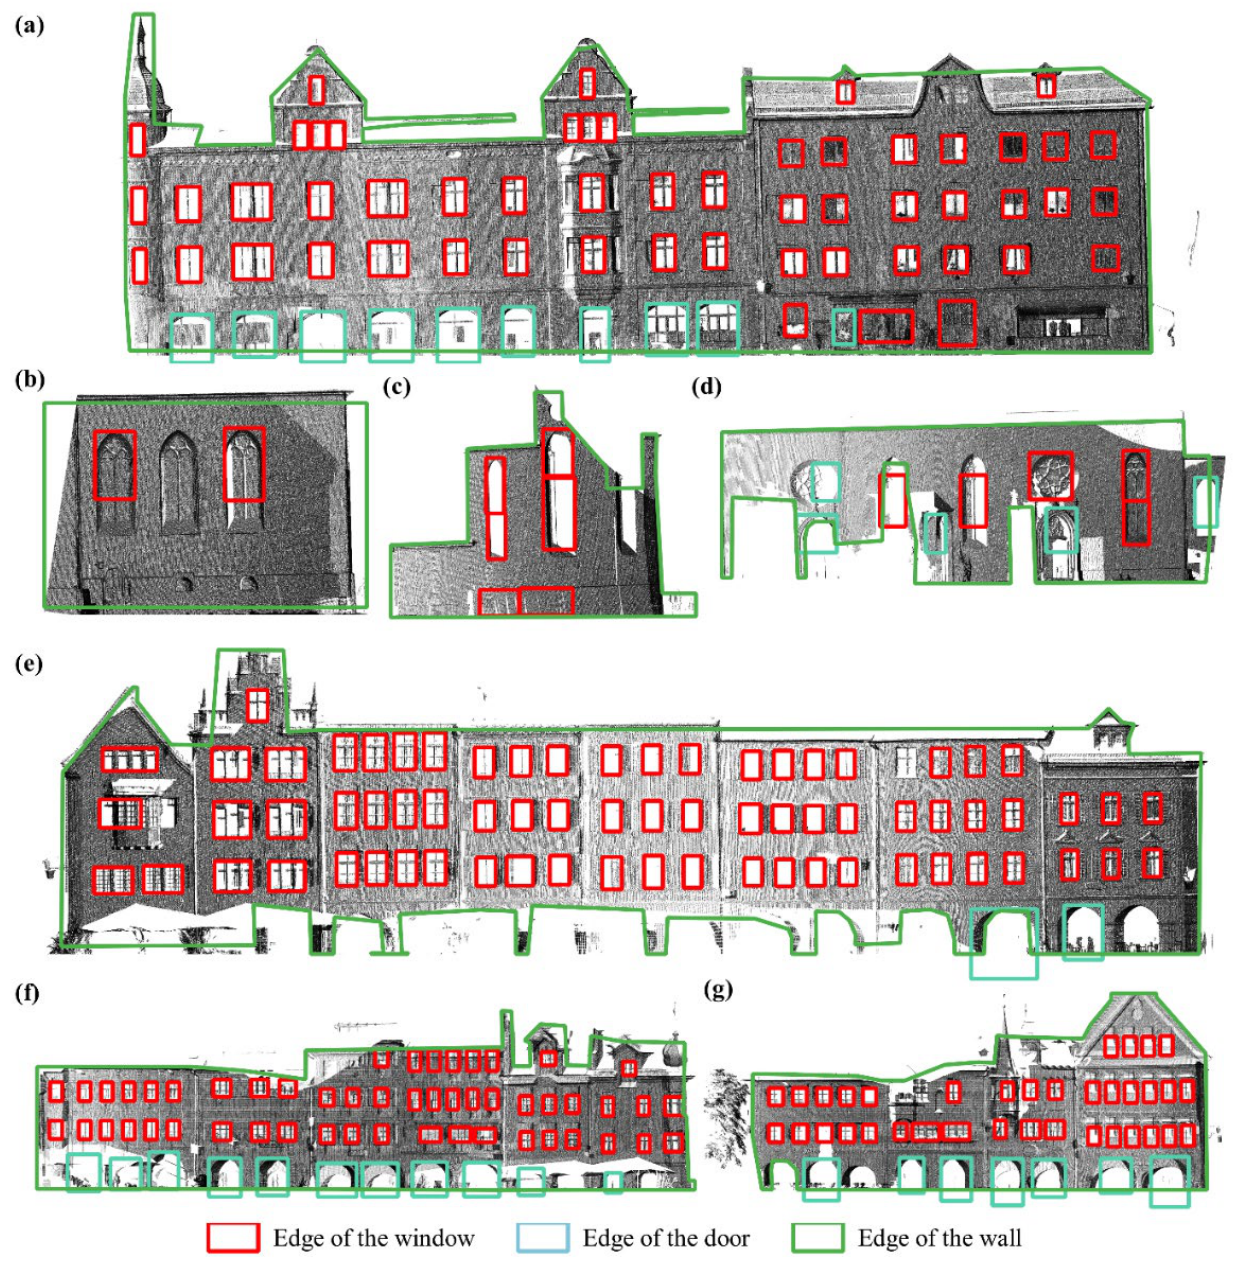
Figure 16. Facade map extraction with the Semantic3D.Net Benchmark dataset: ( a – d ) the facade map extraction results for the “domfountain” scene of facades A1, A3, A4, and A8, respectively; and ( e – g ) the facade map extraction results for the “marketplacefeldkirch” scene of facades C2, C3, and C5, respectively. The red, blue, and green lines in the figure represent the window, door, and building boundaries, respectively; the background image shows the single-band feature image; and the darker the image pixel color is, the greater the number of points contained in the corresponding planar grid. Table 4. Accuracy of window extraction for Semantic3D.Net Benchmark dataset.